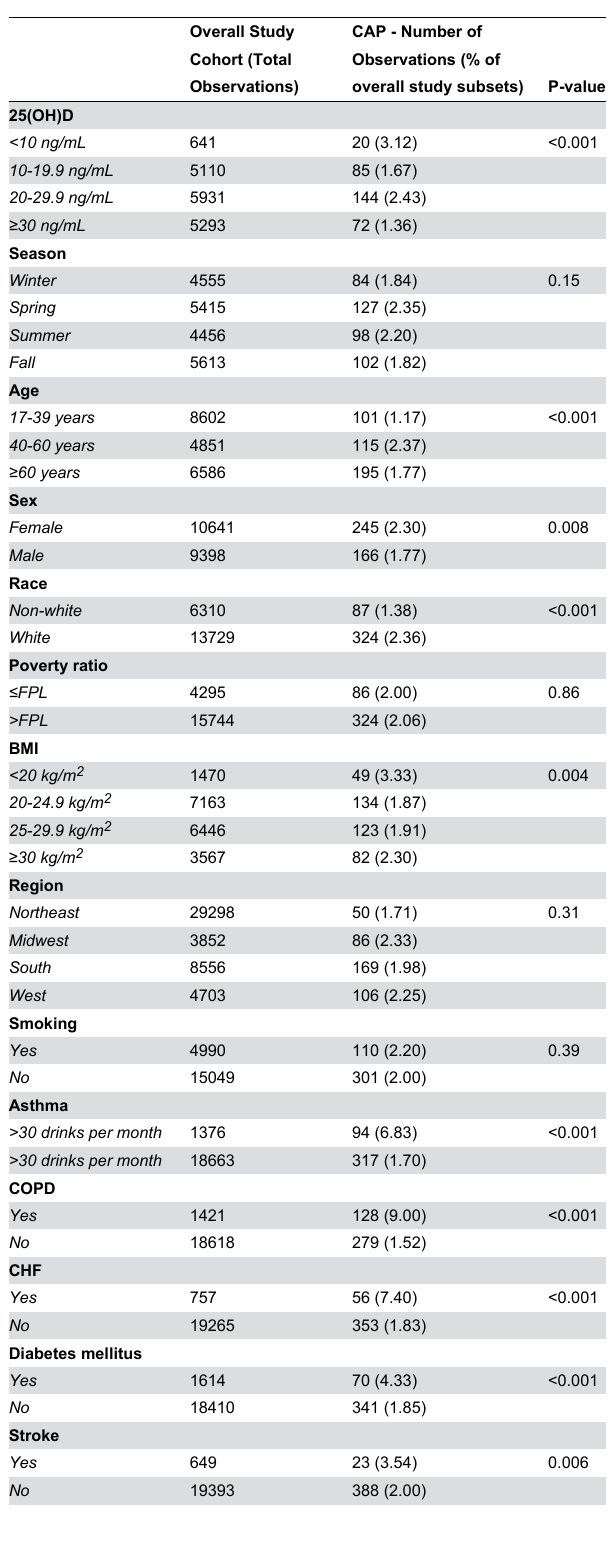
Table 1. Characteristics of the overall study cohort and in the subset with community acquired